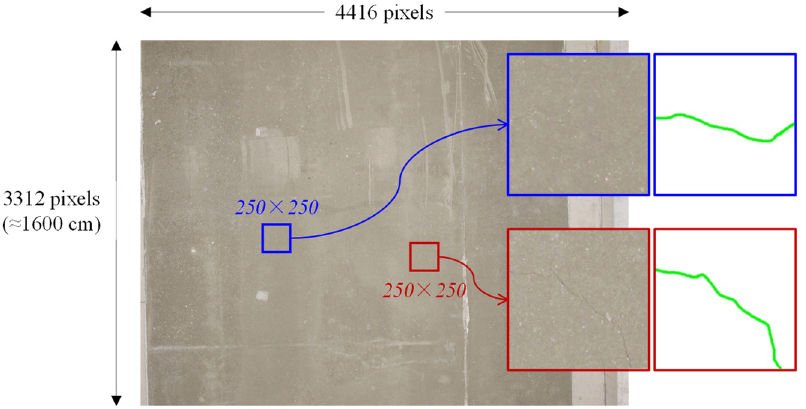
Figure 9. The enlarged views of the 250 × 250 cropped regions containing cracks and the ground truth labeling of the truth labeling of the cracks. Table 2. Comparison of the crack patch datasets in terms of clarity and sharpness